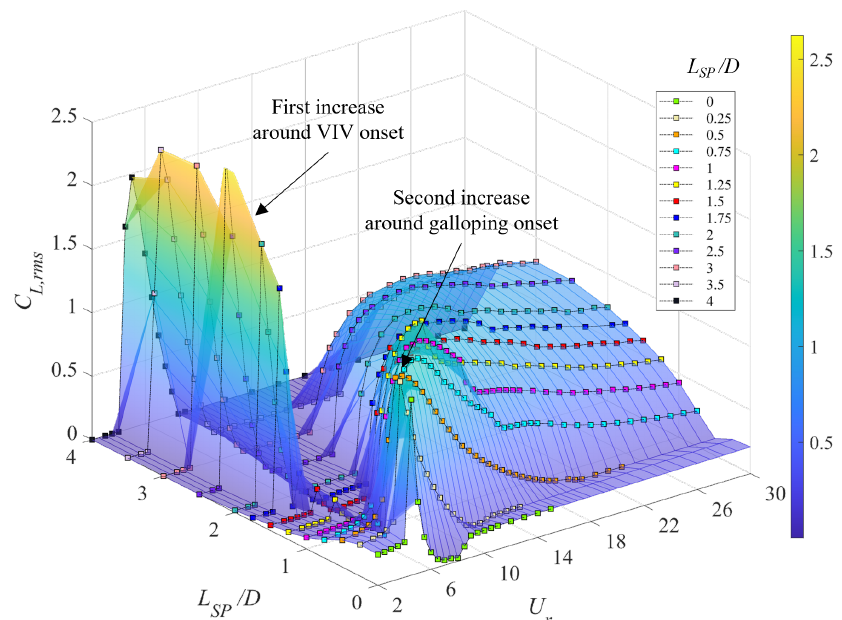
Figure 11. Three-dimensional plot of the root-mean-square lift coefficient C L , rms as a function of the splitter-plate length L SP and the reduced velocity U r .